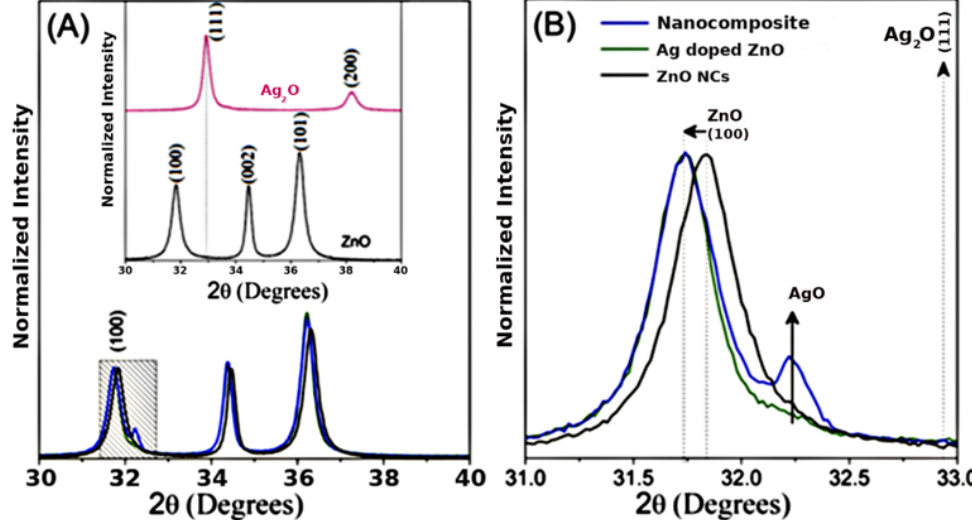
Figure 1. ( A ) X-ray diffraction (XRD) patterns of nanocomposite (blue line), zinc oxide (ZnO) (black line), Ag-doped ZnO (green line), and silver oxide (Ag 2 O) (pink line) nanocrystals. ( B ) The inset shows a magnification around the (100) diffraction